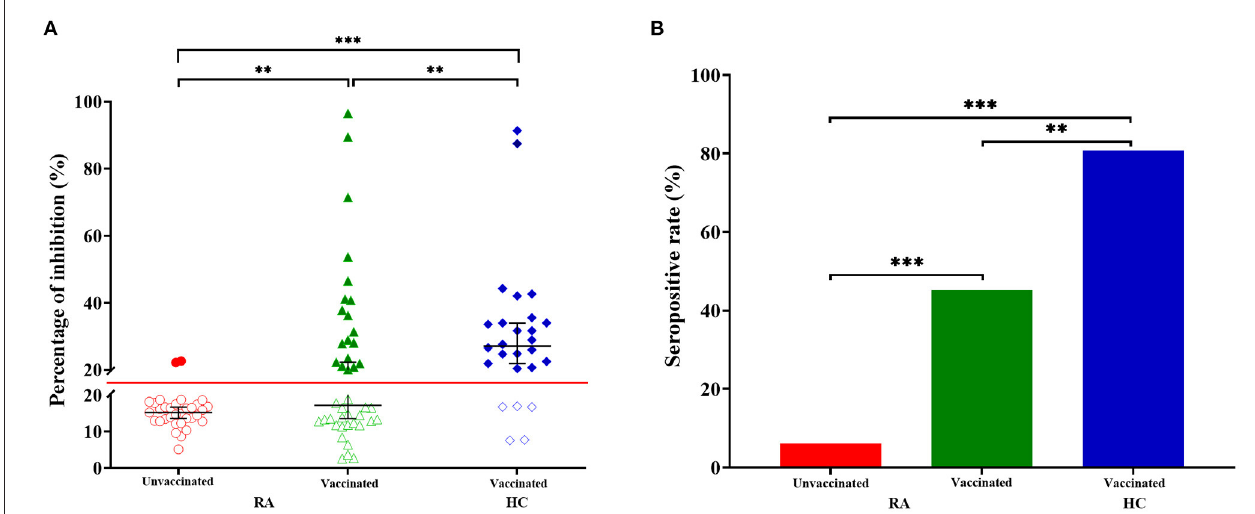
FIGURE 2 | Anti-SARS-CoV-2 antibody responses from RA patients and HC. (A) The percentage of inhibition from individuals who have not been vaccinated RA patients ( n = 33), vaccinated RA patients ( n = 42) and healthy controls (HC, n = 26). Symbols show individual values, red line show the cut-off value (20%), and black horizontal bars show medians. Statistical analysis was done using the Kolmogorov-Smirnov test. Data were presented as median (IQR). ** p < 0.01; *** p < 0.001. (B) Seropositive rate of unvaccinated RA patients ( n = 33), vaccinated RA patients ( n = 42) and healthy controls (HC, n = 26). Statistical analysis was done using the χ ² test. ** p < 0.01; *** p < 0.001.